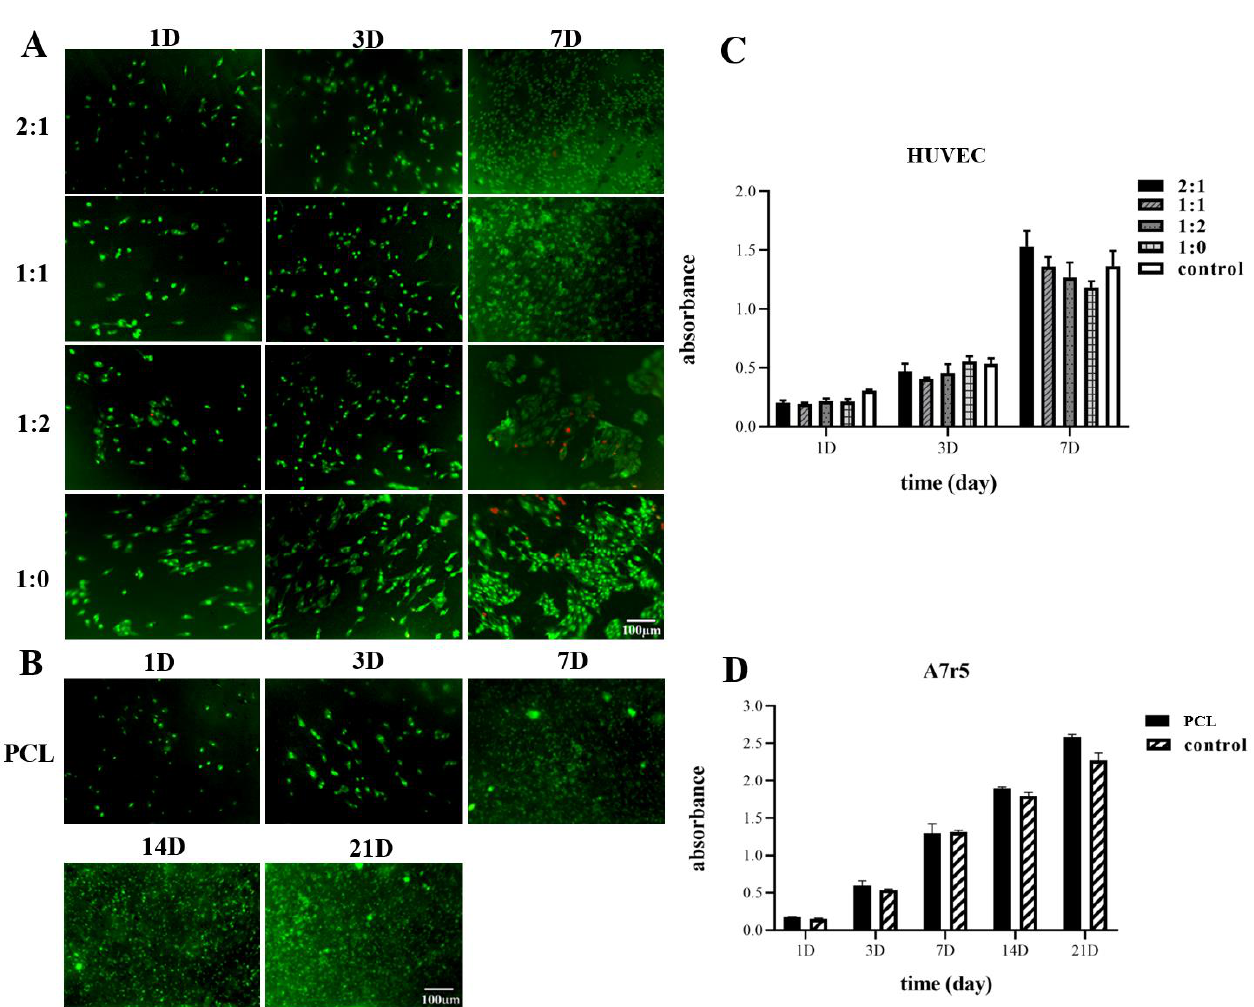
Figure 5. Morphology and proliferation evaluations of cells on different scaffolds. ( A ) AO/EB staining of HUVEC cells grown on four different scaffolds. ( B ) AO/EB staining of A7r5 grown on the outer layer. ( C ) Viability of HUVEC cells measured by the CCK-8 assay. ( D ) Viability of A7r5 measured by the CCK-8